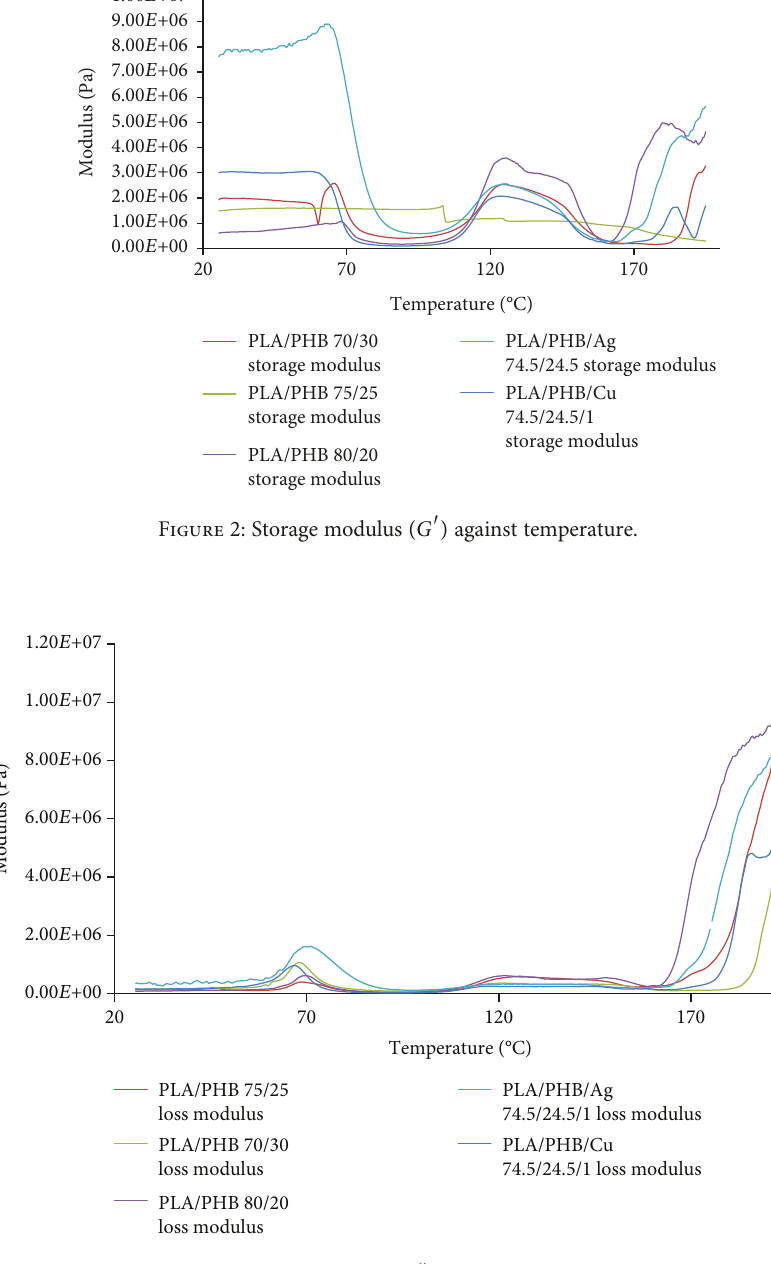
Figure 3: Loss modulus ( G ″ ) against